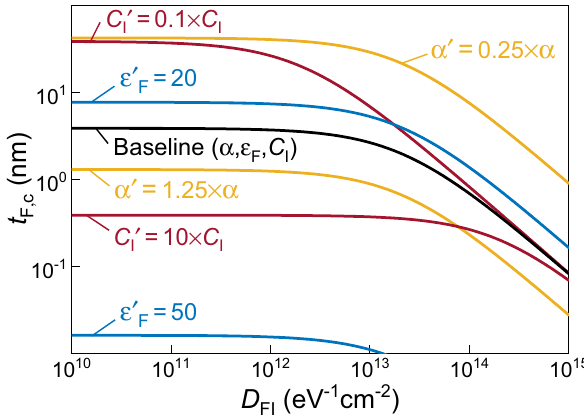
Fig. 4 The critical ferroelectric thickness decreases with increasing interface state density. The critical ferroelectric thickness t F,c of the free- charge-conducting metal-ferroelectric-insulator-metal ( c -MFIM) system (Fig. 1a) is plotted as a function of the interface state density D FI for different values of the Landau parameter α (yellow lines), the background permittivity of the ferroelectric ε F (blue lines), and the capacitance of the insulator layer C I = ε I / t I (red lines). The baseline curve (black line) corresponds to the parameter values: α = − 1.1 × 10 9 mF − 1 , ε F = 35, and C I = 3.45 μ F cm − 2 . The c -MFIM system is characterized by a hysteretic device operation if the thickness t F of the (perfectly uniform and coherent) ferroelectric layer is larger than the critical thickness t F,c ( t F > t F,c ). Note that the in fl ection point in the curves occurs around D FI = C I / q 2